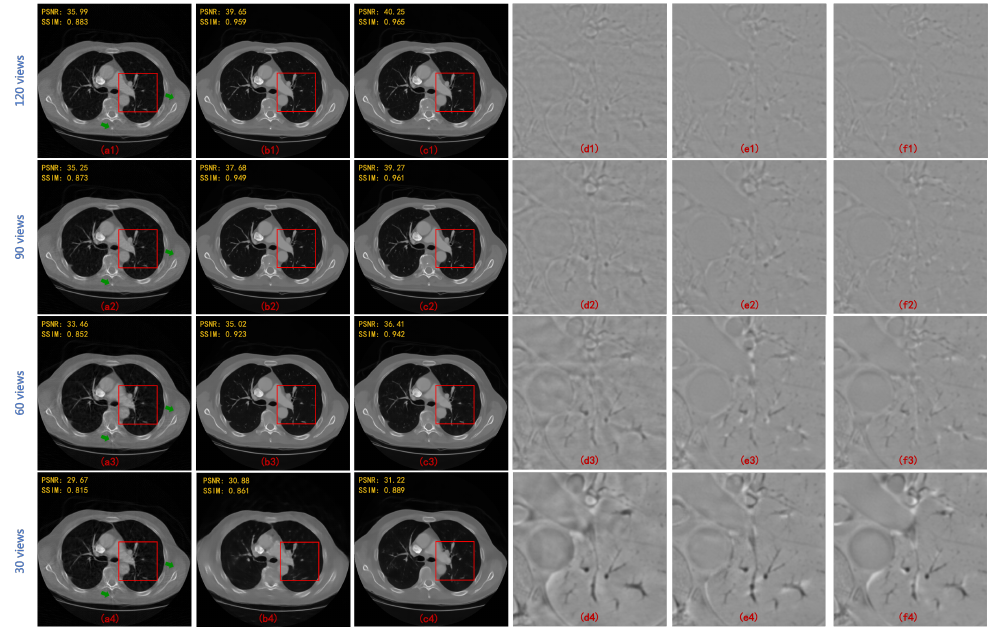
Figure 6. Reconstruction results of MWCNN applied to different domains at different angular intervals and the error maps of enlarged regions. ( a ) image domain; ( b ) radon domain; ( c ) hybrid domain; ( d ) error map of ( a )—box-region; ( e ) error map of ( b )—box-region; and ( f ) error map of ( c )—box-region. The numbers ( 1 – 4 ) after the letter serial numbers represent the results of 120, 90, 60 and 30 projections,